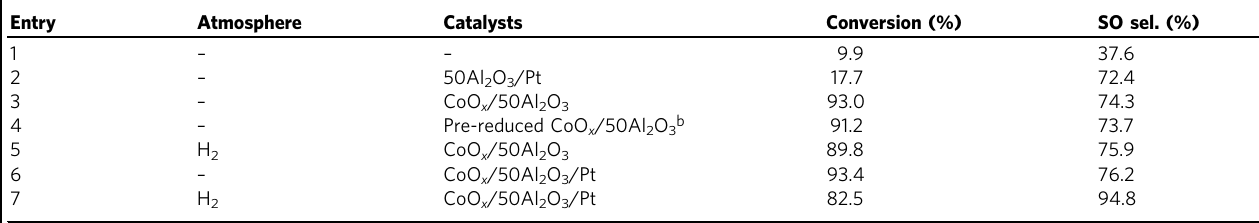
Table 1 Catalytic performances of the catalysts for styrene epoxidation reaction in different conditions a . Entry Atmosphere Catalysts